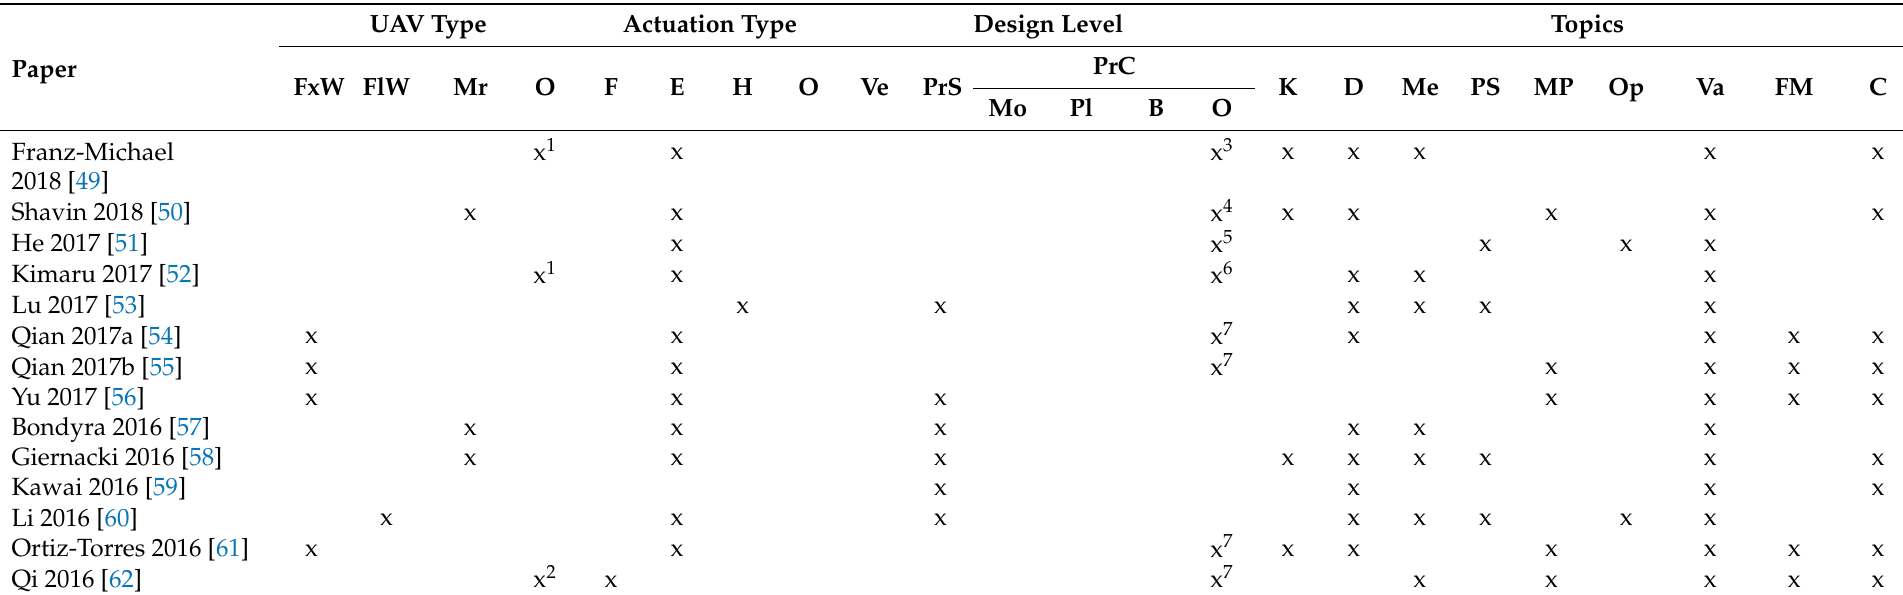
Table 6. Evaluation of the papers categorized in the controls, identification, modeling category from 2016 to 2018, according to the taxonomy referring to the paper content.